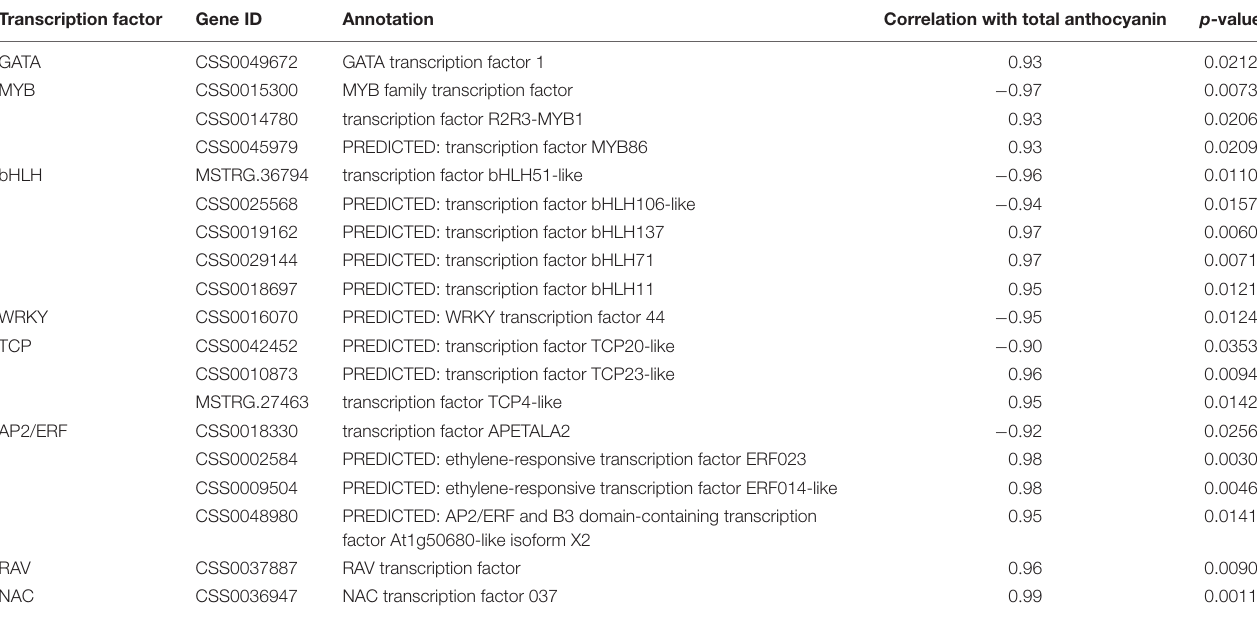
TABLE 1 | The candidate TFs involved in anthocyanin